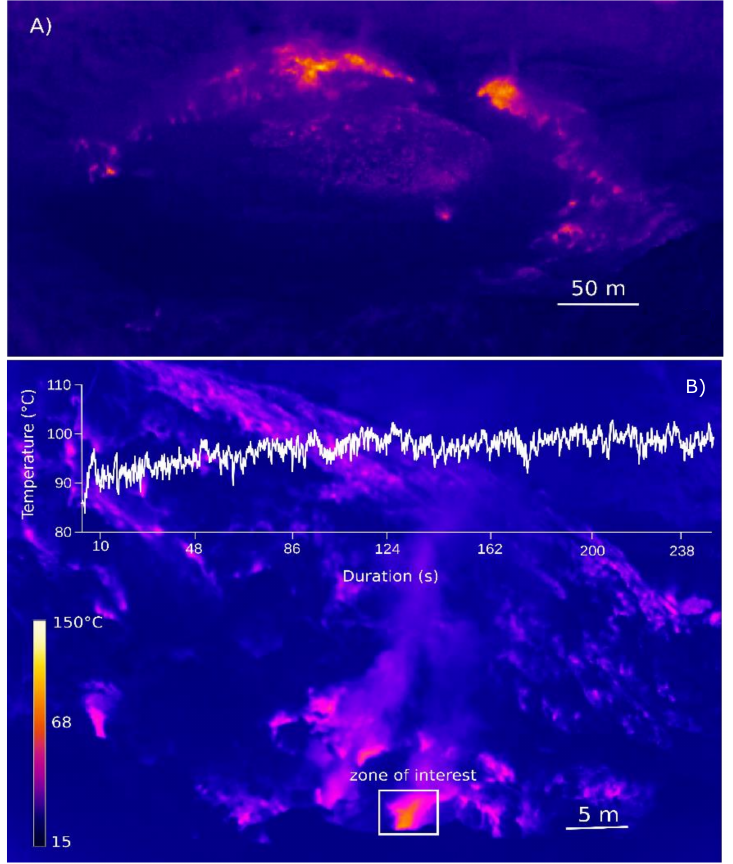
Figure 5. Heat distribution in Awu’s crater highlighting the heated surfaces around the lava dome ( A ). The surface temperature obtained from a continuous thermal recording is ~100 ◦ C ( B ). The most heated surface is situated in the northern part of the